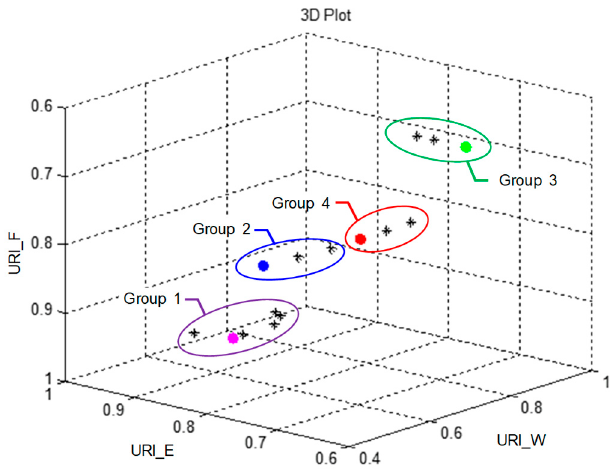
Figure 7. MOGA Pareto solutions and four groups based on self ‐ organizing map (SOM) clustering analysis.